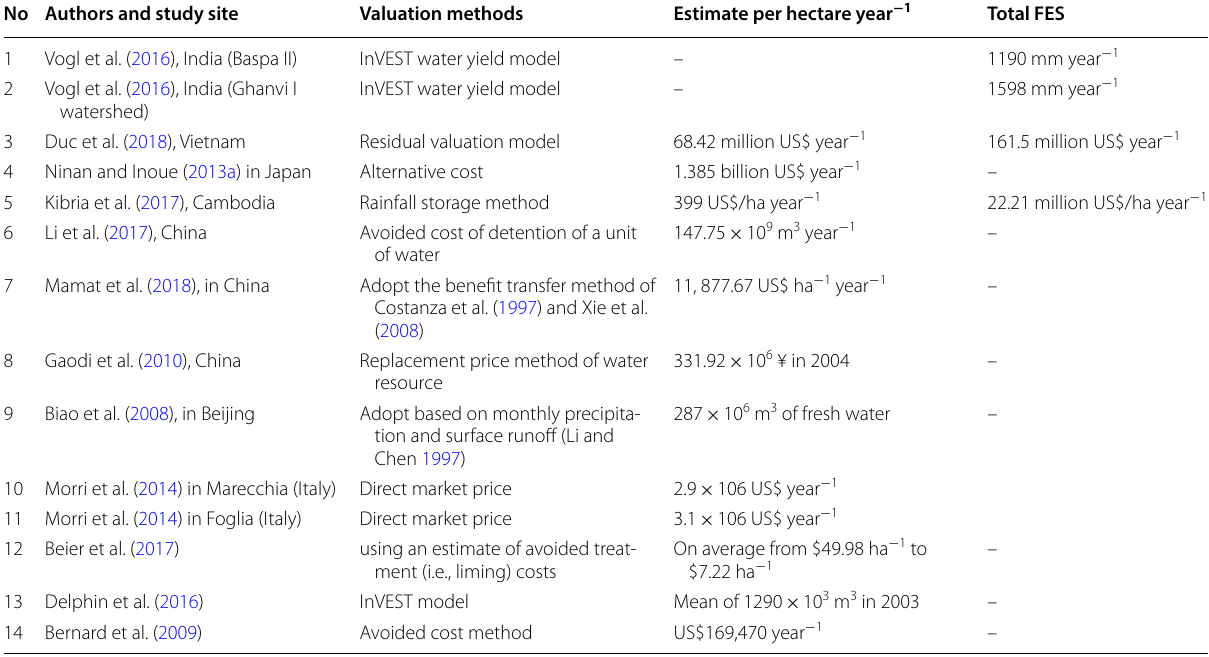
Table 3 Reviewed studies dealing with water yield including the methodology and monetary value